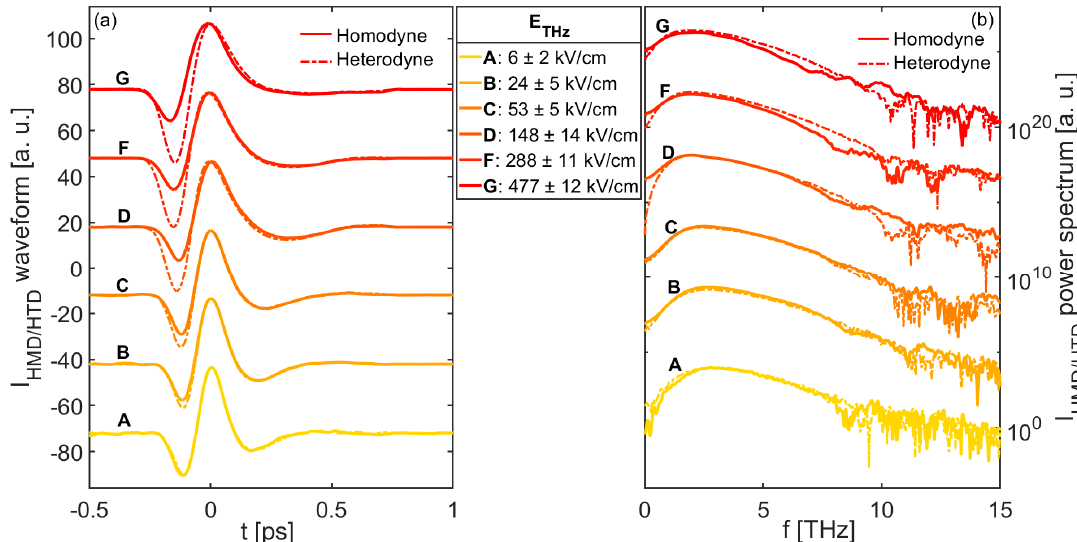
Figure 2. ( a ) Temporal waveforms and ( b ) their corresponding spectra retrieved via the homodyne (solid line) and heterodyne (dashed line) schemes at different THz electric field strengths, and at a fixed bias voltage of V DC ( E DC ≈ 140 kV/cm). Curves are normalized to their own maxima and vertically shifted for clarity.